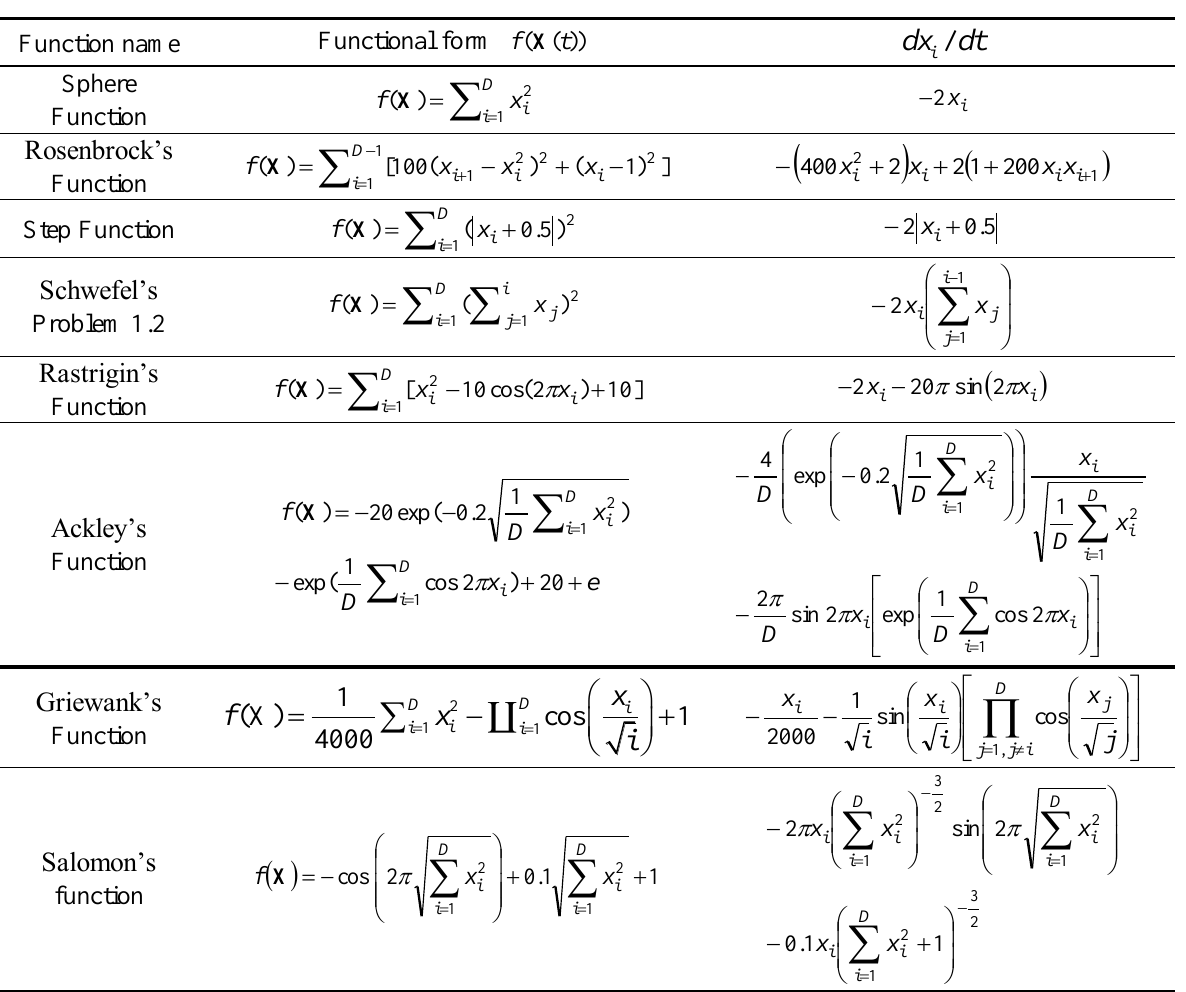
Table 1. The derived dynamics for the selected benchmark